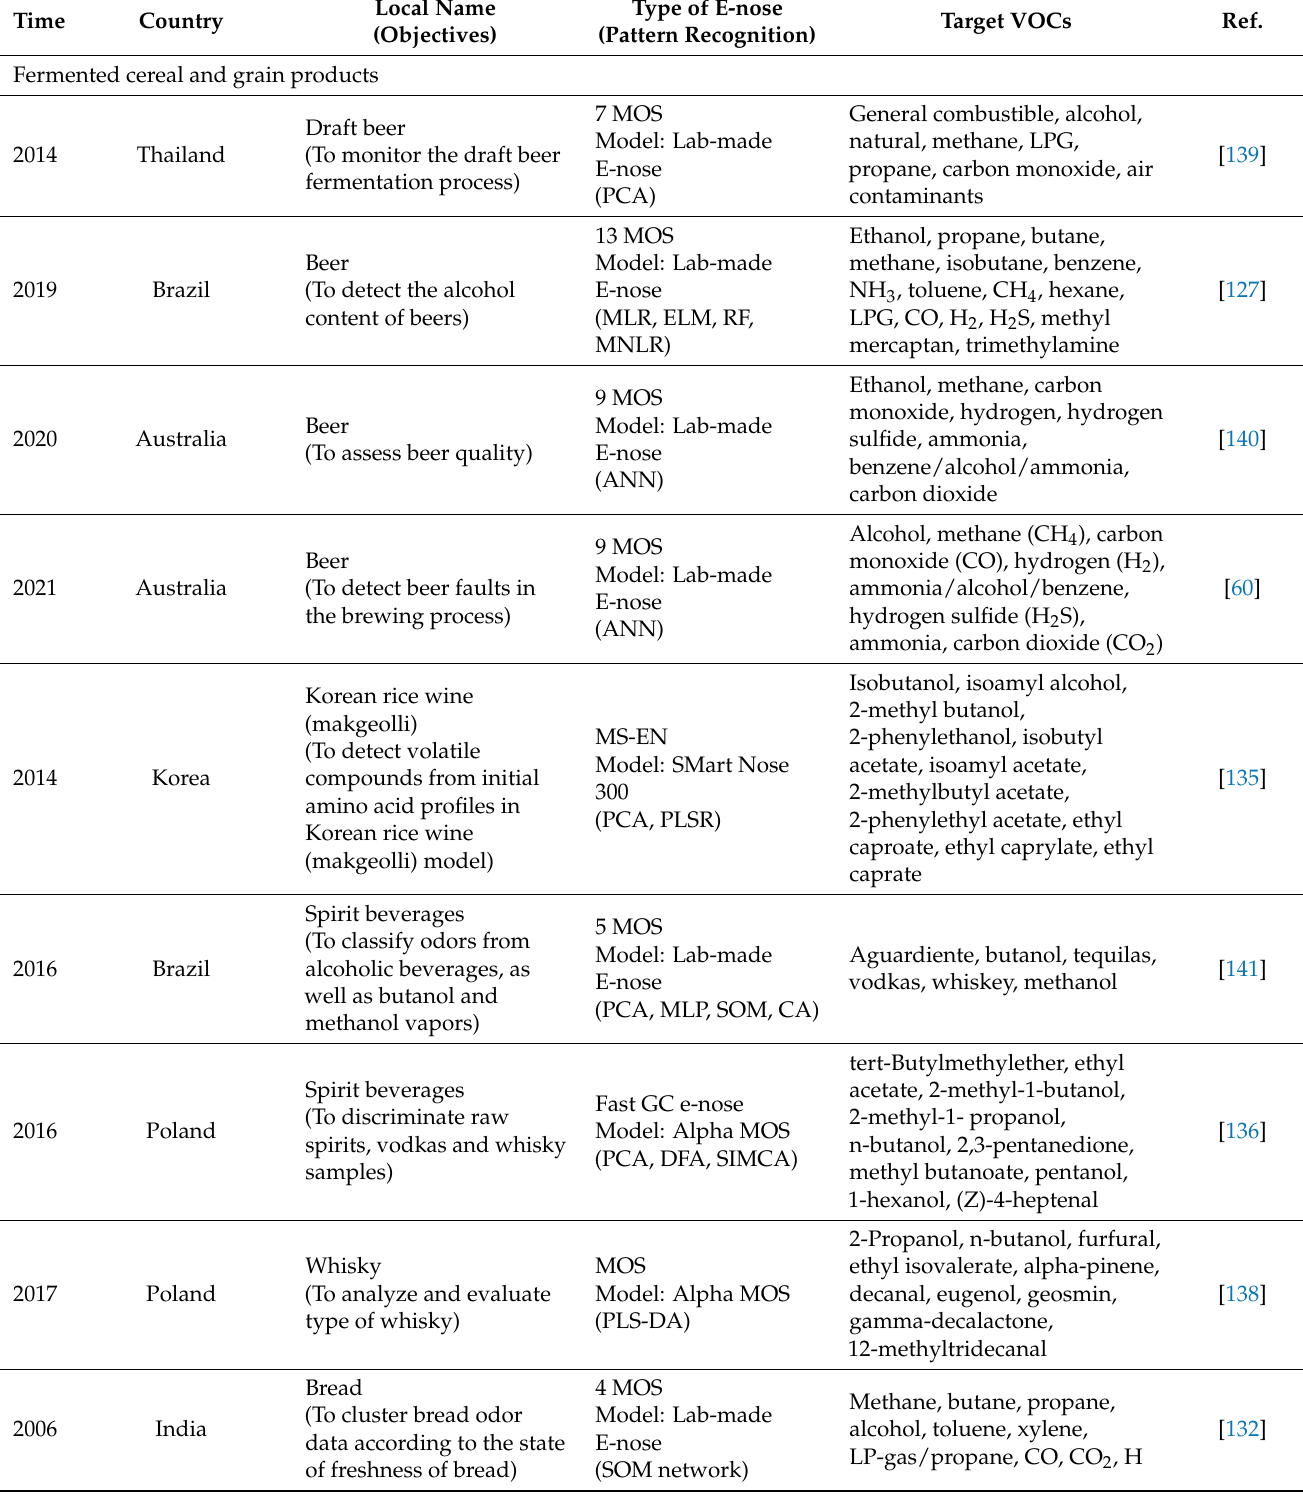
Table 1. The E-nose for alcoholic